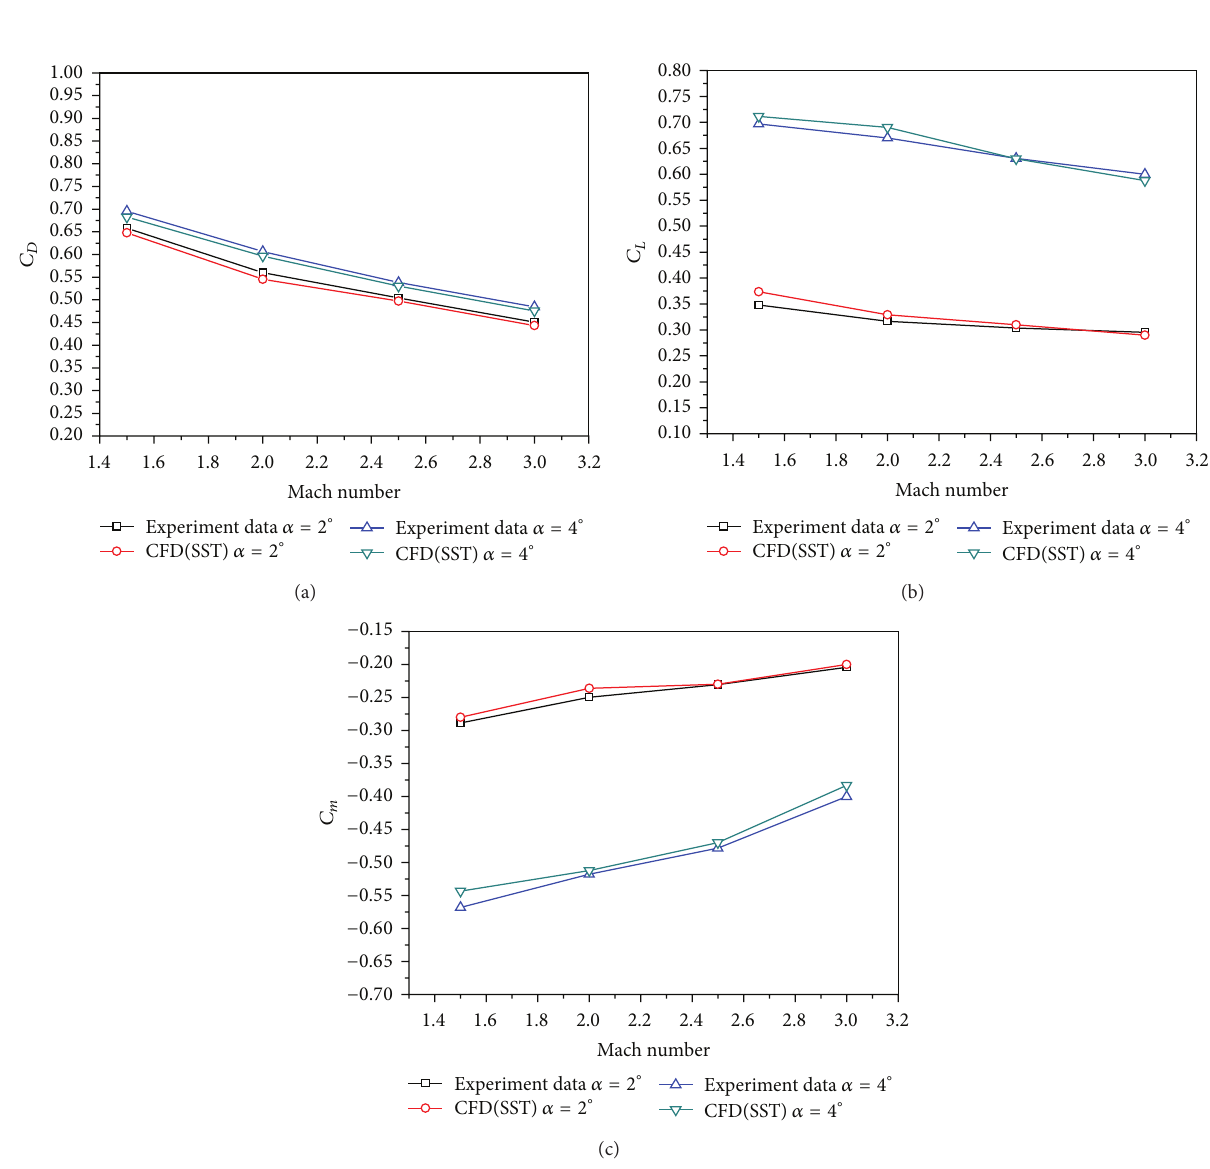
Figure 5: Aerodynamics coefficients versus Mach number (Ma): (a) 𝐶 𝐷 , (b) 𝐶 𝐿 , and (c) 𝐶 𝑚